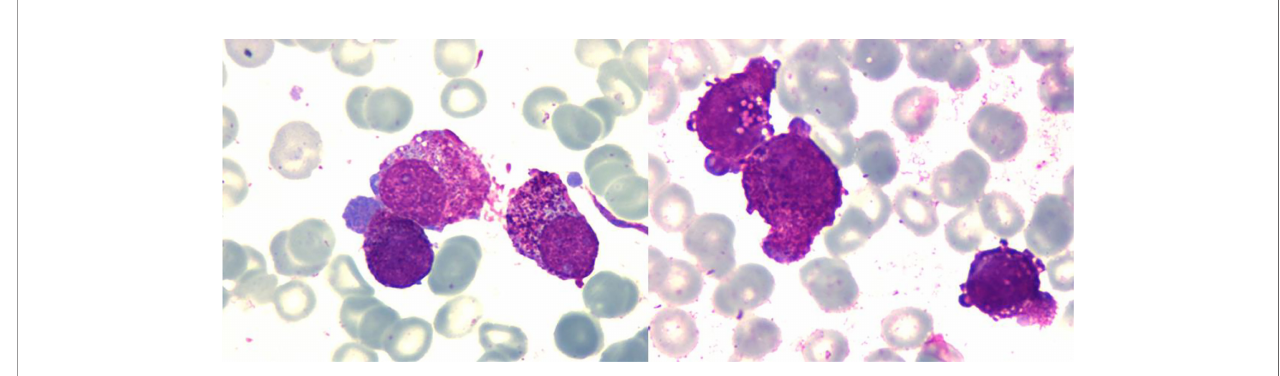
FIGURE 3 | Promyelocytes contained round nuclei and abundant cytoplasm, but no